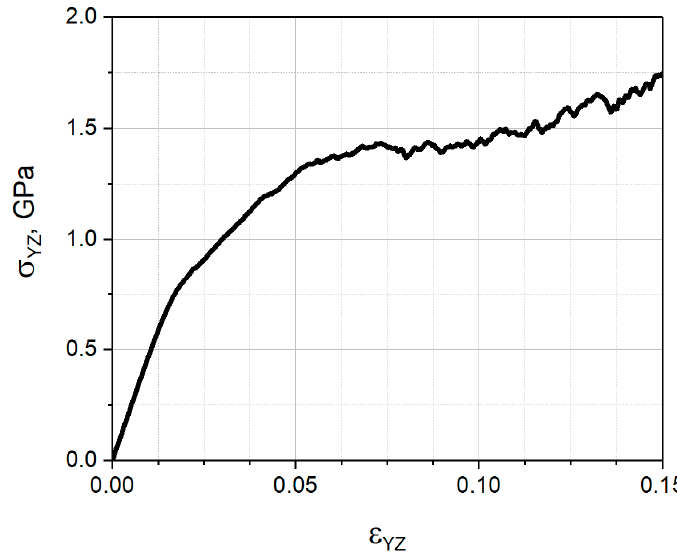
Figure 13. Stress–strain dependence for the bcc30_L1 sample under shear.